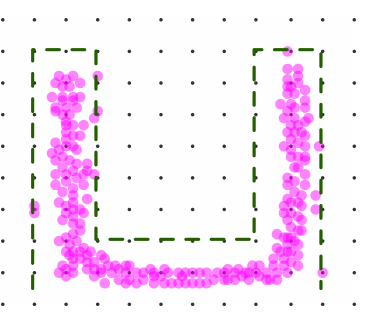
Figure 6. An example of the HOG feature representation Adapated from